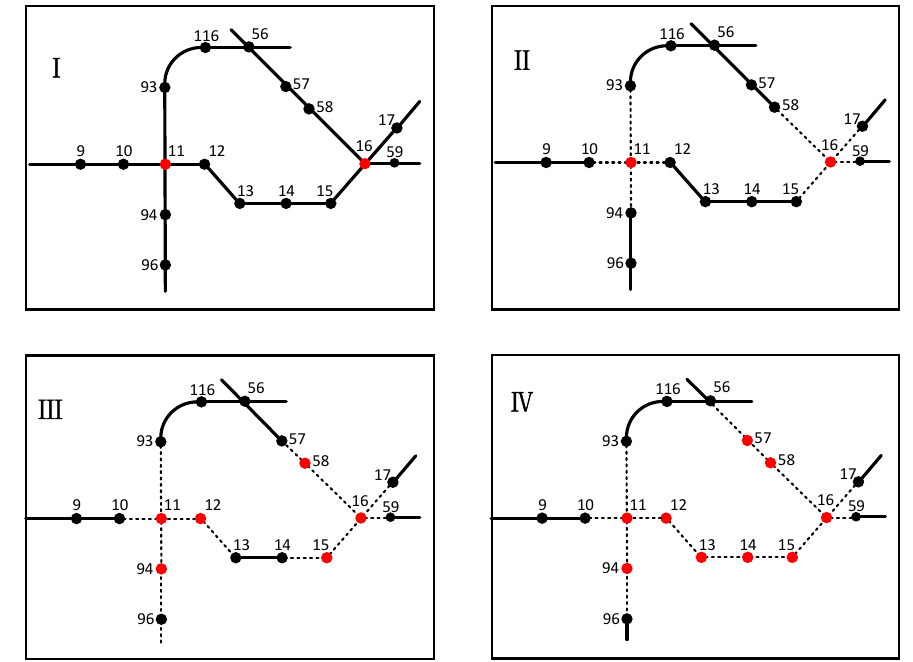
Figure 12. Network cascading failure caused by node 11 and 16 failure.